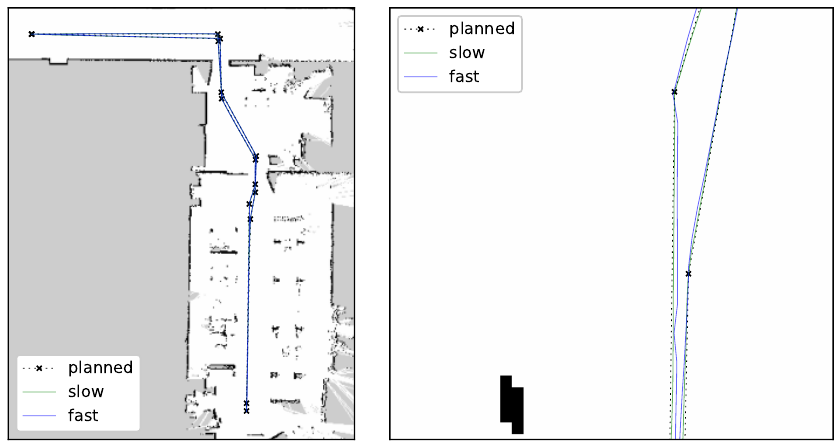
Figure 15. Paths: planned and the travelled in passes 1 to 3—whole path and a zoom-in.